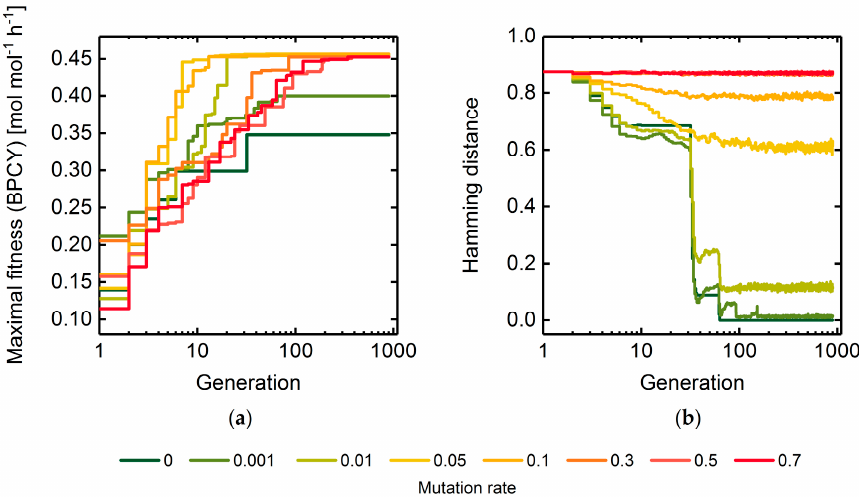
Figure 2. Maximal fitness ( a ) and hamming distance ( b ) across the populations of every thread in each generation using mutation rates between 0 and 0.7. Deletion of maximally five reactions were allowed while using succinate BPCY as the engineering objective. Hamming distance progressions for mutation rates 0.5 and 0.7 overlap each other. Metabolites 2018 , 8 , x